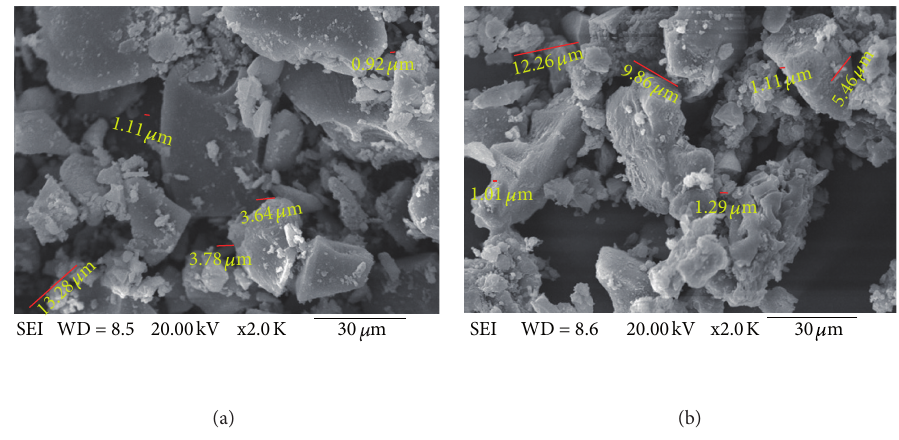
F 2: SEM images of (a) AT-silica and (b) Al/AT-silica.